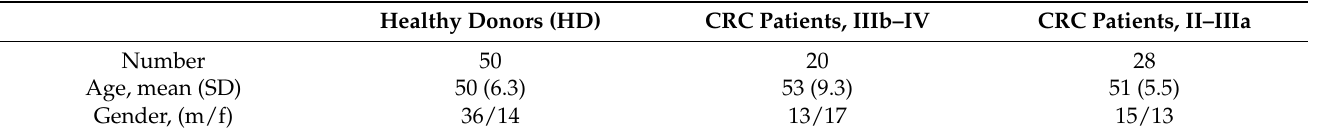
Table 1. Clinical